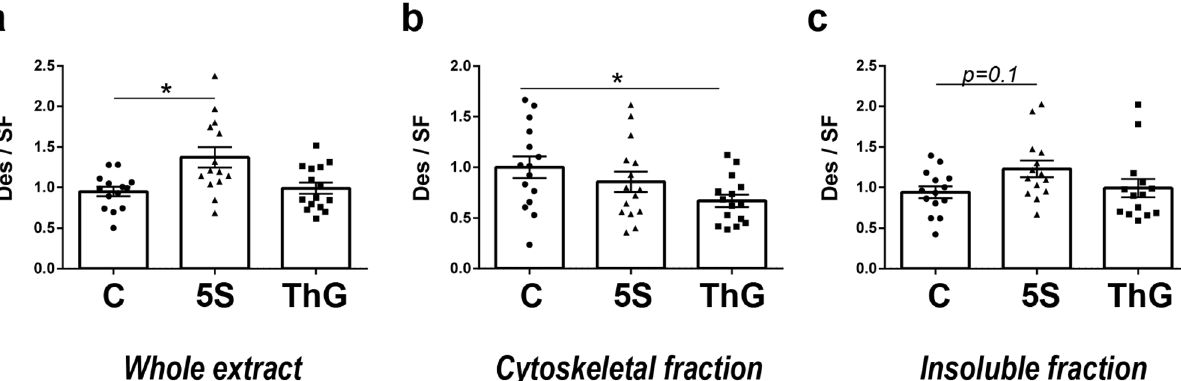
Figure 3. Quantification of desmin partition toward cytoskeleton or insoluble protein material. Twenty µg of proteins sample extracts (RIPA for desmin protein expression, and SDS-resolubilized extracts or DIB for partition toward cytoskeleton or insoluble material, respectively) were resolved on AnykD Stain-free gels and analysed by western blot for desmin detection. ( a ) Desmin protein level in whole proteome. ( b , c ) Changes in desmin partition towards cytoskeleton ( b ) or insoluble protein material ( c ) from untreated (C, ● ), Ac 4 - 5S-GlcNAc- and Thiamet G-treated myotubes (5S, ▲ and ThG, ■ respectively). Data were expressed as mean ± SEM and compared with the control condition. **p < 0.01: significantly different from control (n = 15; N = 3 independent